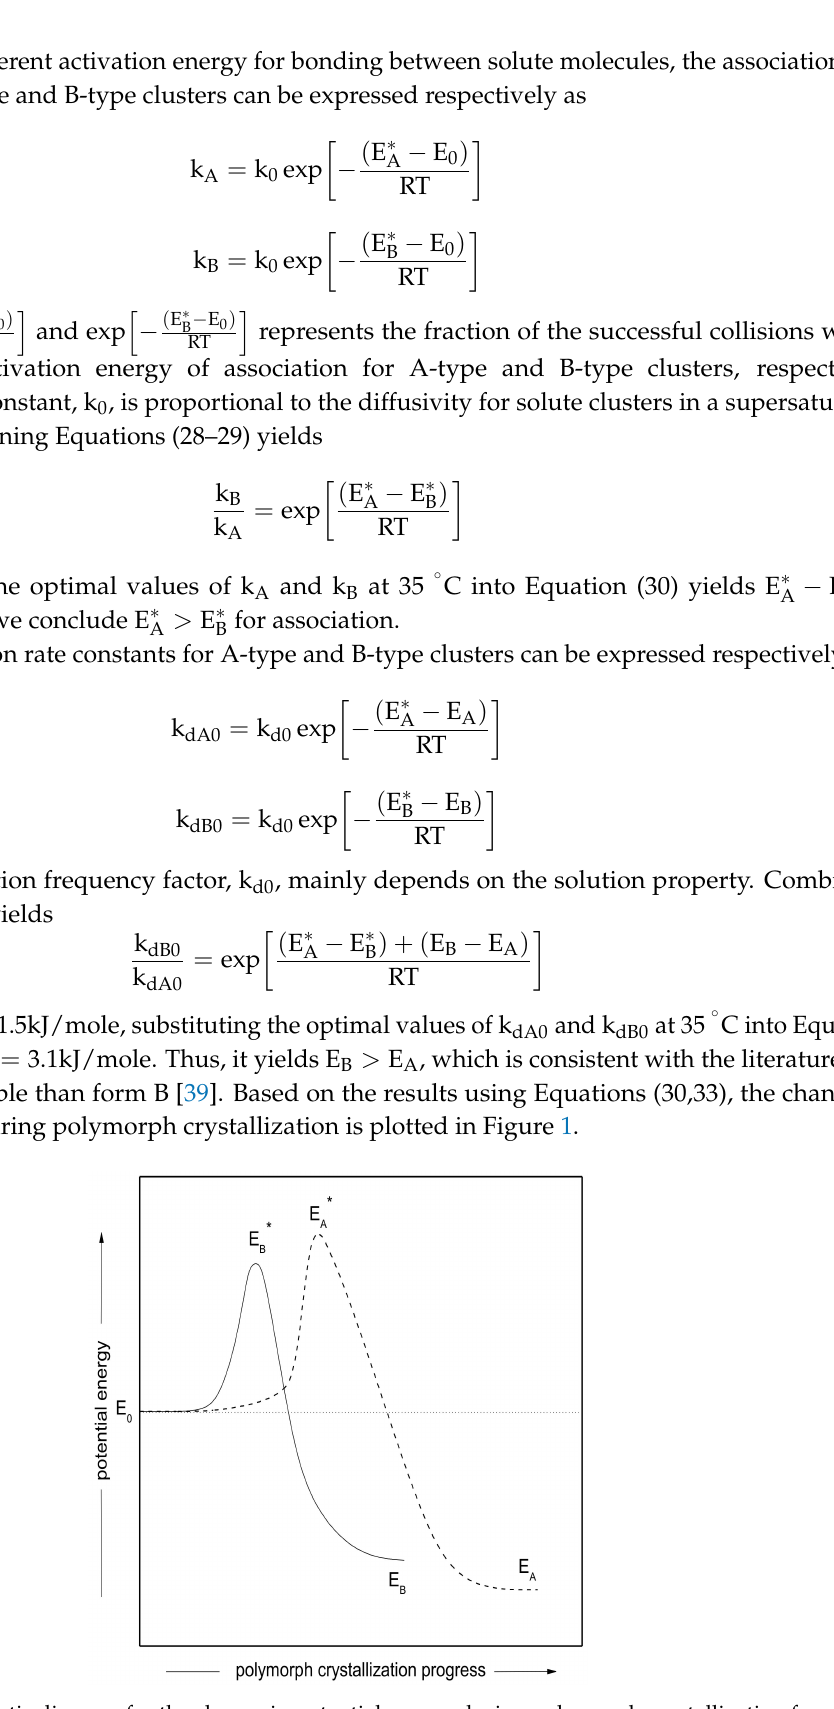
Figure 1. Schematic diagram for the change in potential energy during polymorph crystallization from the initial state to two different